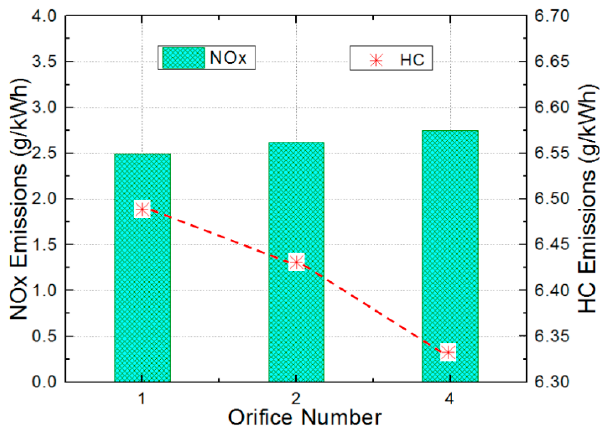
Figure 11. NOx and HC emissions with different injector orifices.